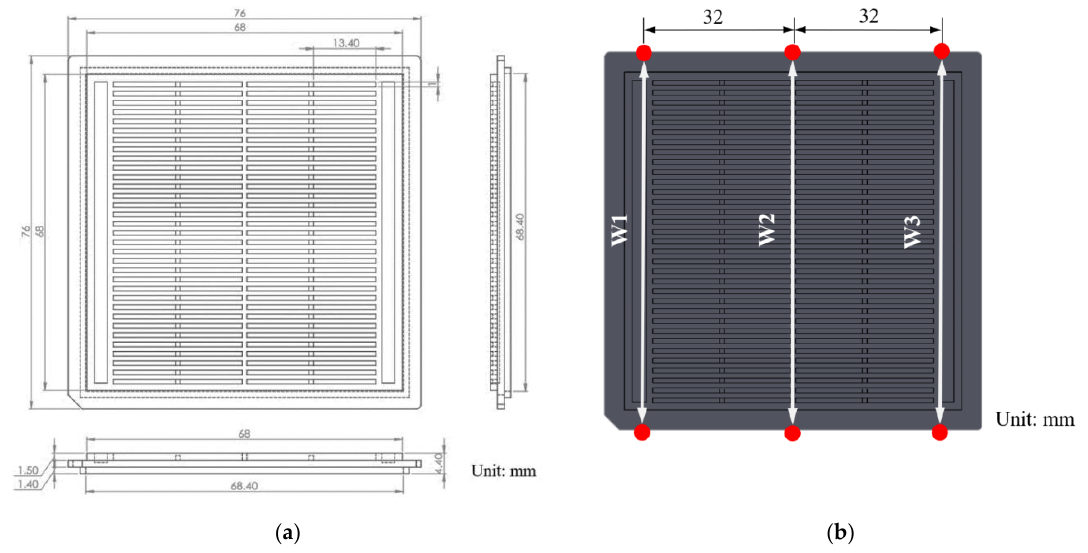
Figure 4. ( a ) Geometry of the Integrated Circuit ( IC ) tray and ( b ) six measurement positions for width deviations.